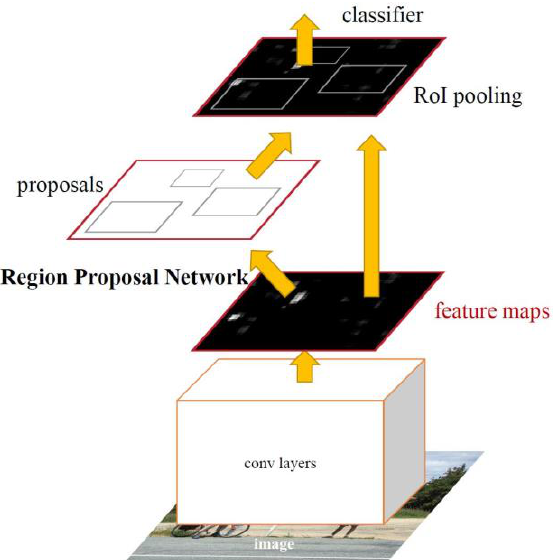
Figure 2. Illustration of the faster R-CNN model (by courtesy of Cornell University